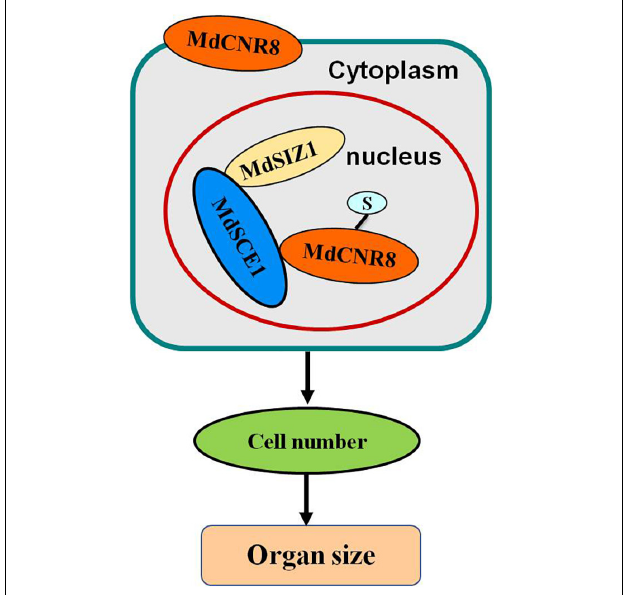
FIGURE 9 | Model depicting how SUMOylation of MdCNR8 regulates MdSIZ1-mediated cell number and organ size in plants (S, SUMO).